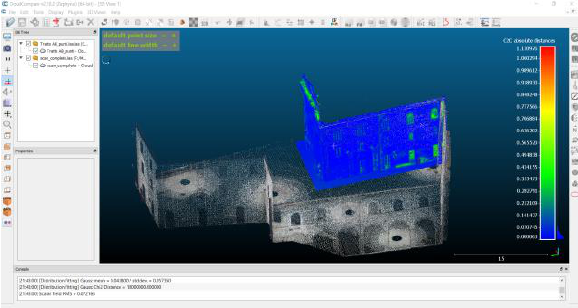
Figure 7. Import of laser scanner and photogrammetric clouds inside the Cloudcompare software